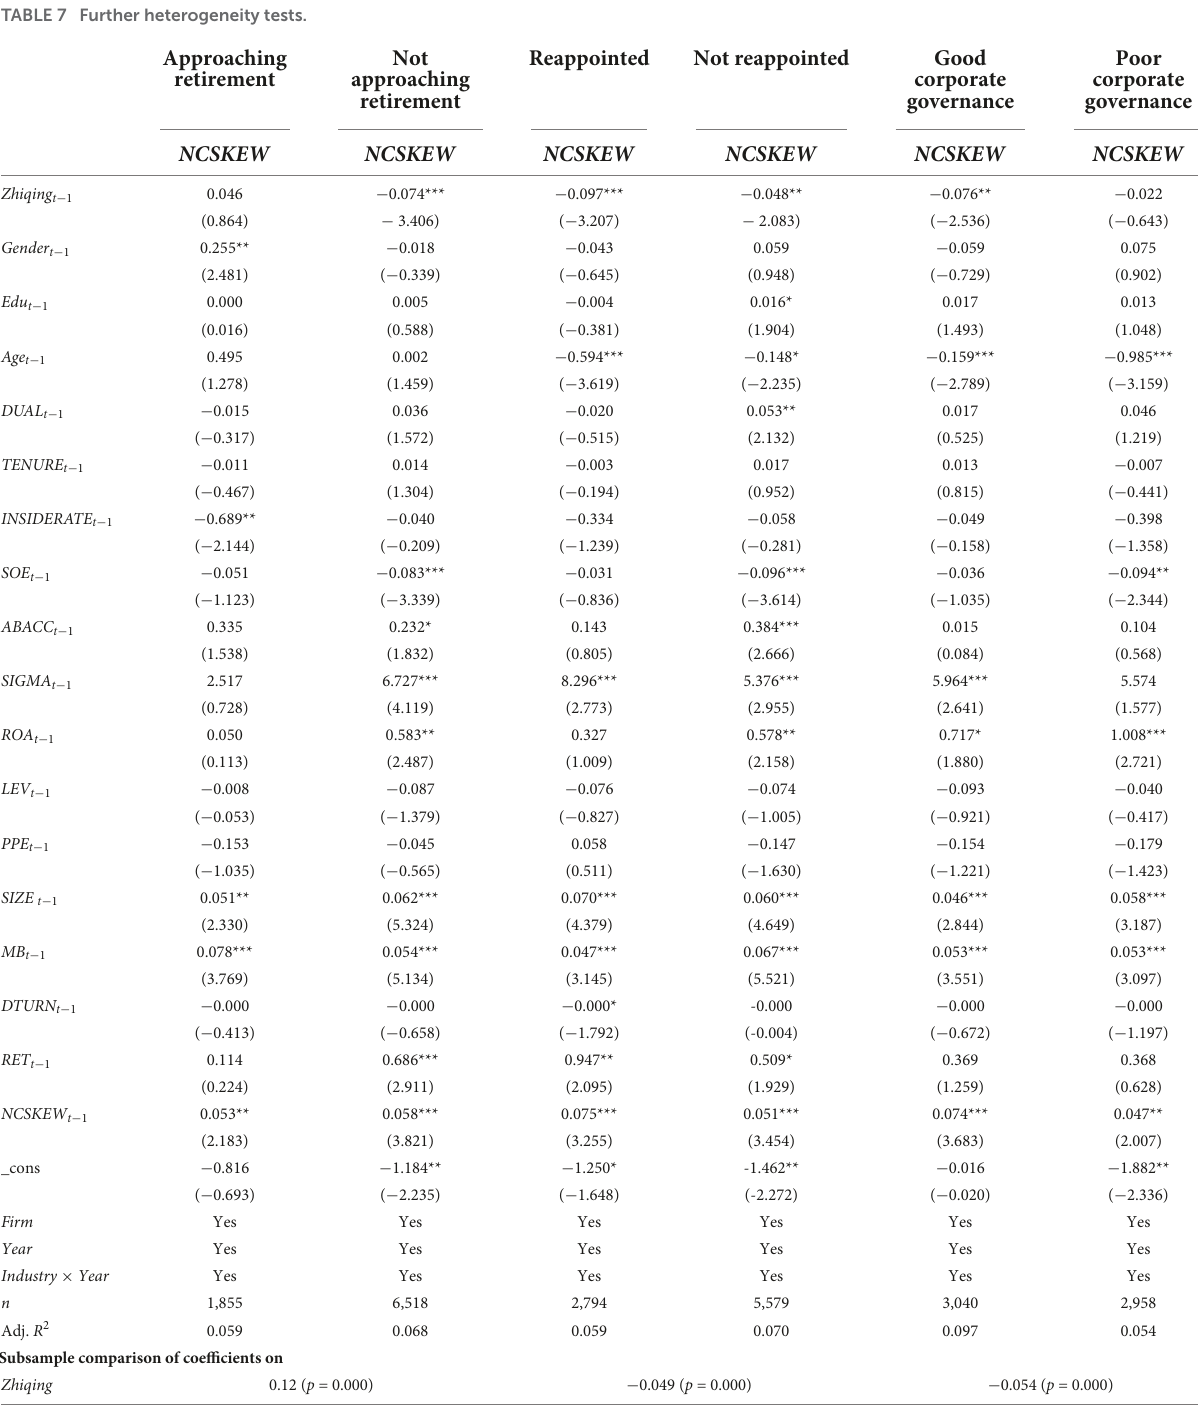
TABLE 7 Further heterogeneity